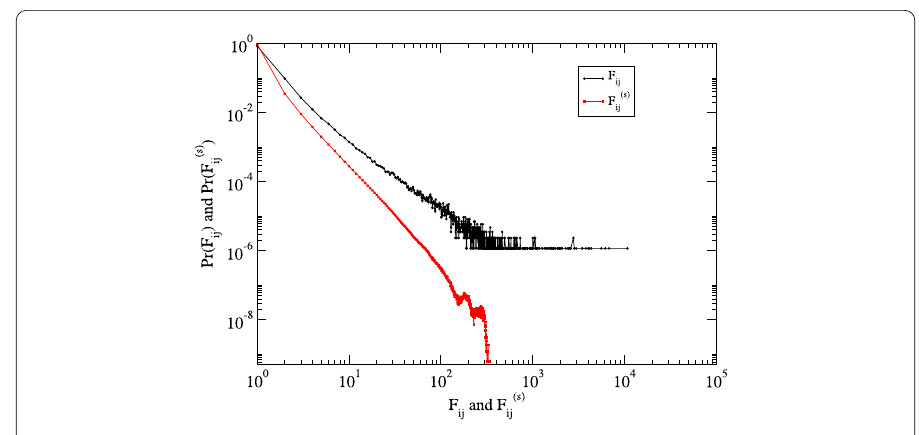
Figure 19 Distributions Pr( F ij ) (black ‘ (cid:24) ’) and Pr( F ( s ) ) (red ‘ (cid:3) ’) for M = 10 3 Monte Carlo realizations. The ij distributions differ widely, with Pr( F ( s ) ij ) considerably steeper than Pr( F ij ), illustrating the way that the condition to fix τ i for each node has the effect of spreading flows evenly over the network, thereby eliminating large flow between node